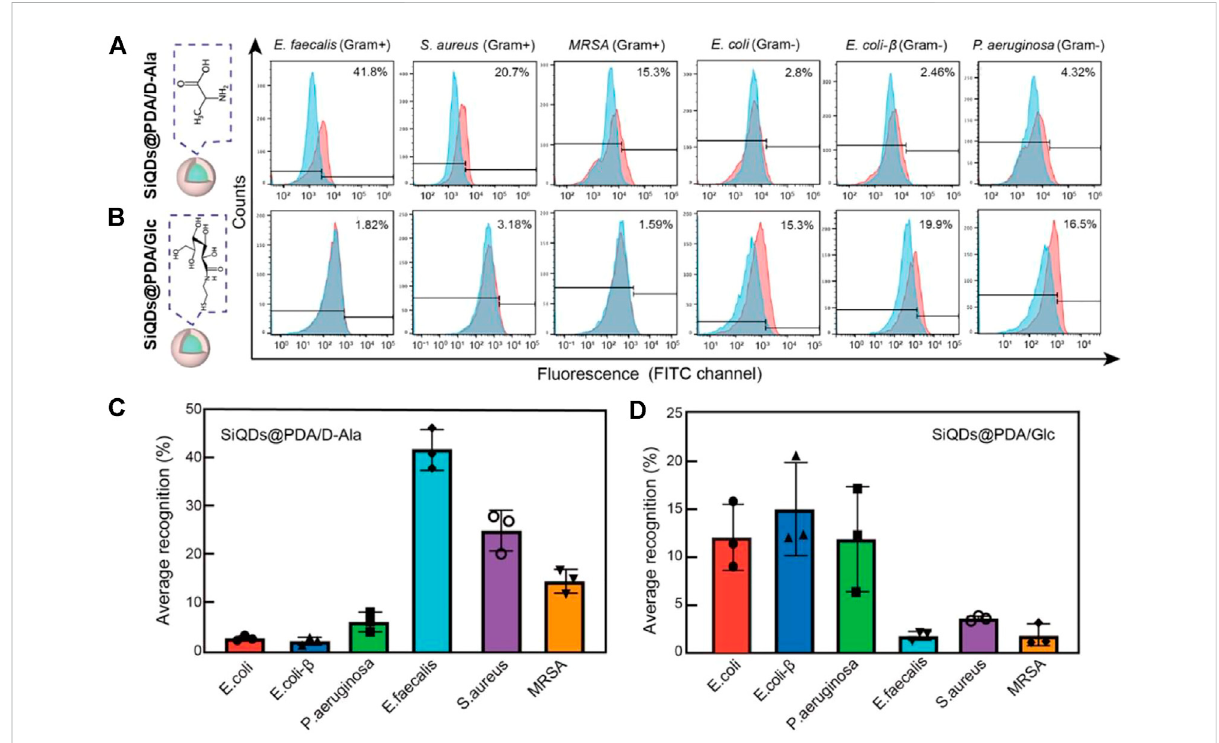
FIGURE 3 Gram-speci fi crecognitionofSiQDs@PDA/D-AlaandSiQDs@PDA/Glc. (A,B) Representative fl owcytometryhistogramscollectedfrombacteria co-incubation with SiQDs@PDA/D-Ala and SiQDs@PDA/Glc. (C,D) Average recognition values for six different types of bacteria. Data = mean ± SD, n =